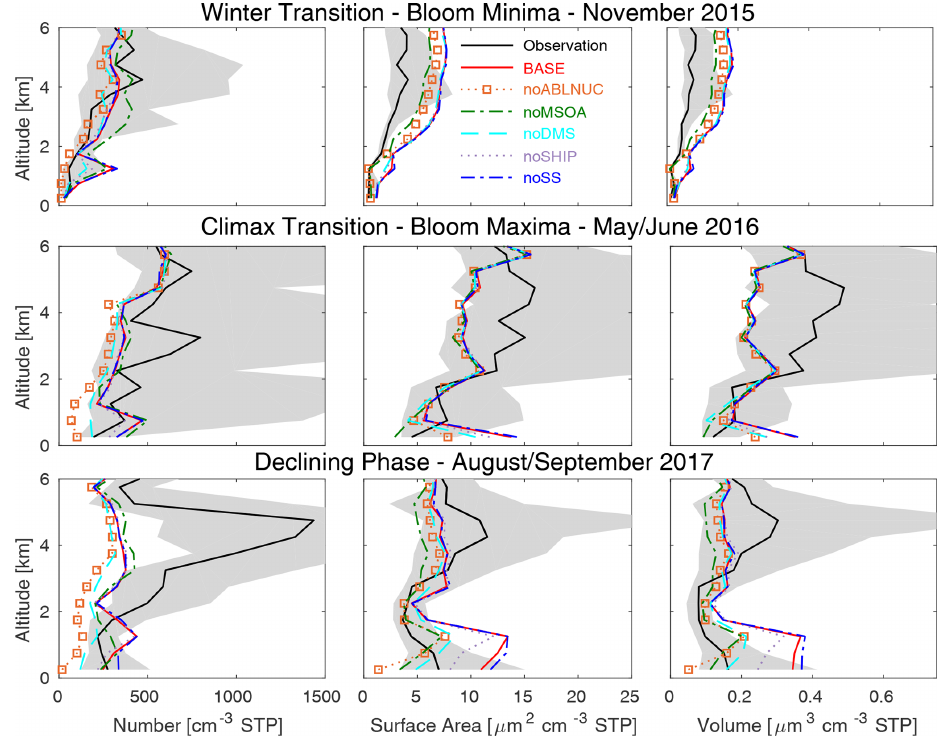
Figure 3. Vertical profiles of NAAMES campaign-median integrated SMPS observations aboard aircraft at standard temperature and pres- sure (STP) for particles with diameters of 10 to 282nm (black, with 25th–75th percentiles in grey) and for the six GEOS-Chem-TOMAS simulations described in Table 1 (color-coded as shown in the legend). All measurement and model output is binned at 500m resolution, and campaign-median values are plotted at the midpoint of each bin starting at 250m above the surface. Lines show linear interpolation between these